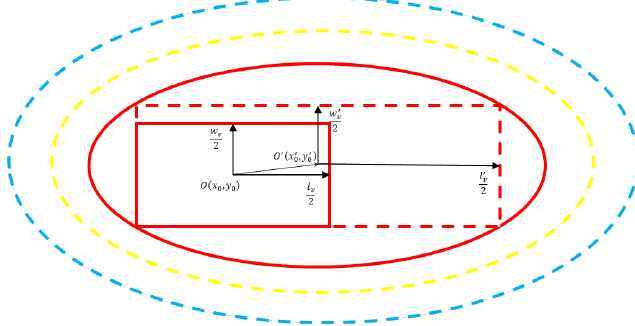
Figure 6. Overhead projection of dynamic safety field.